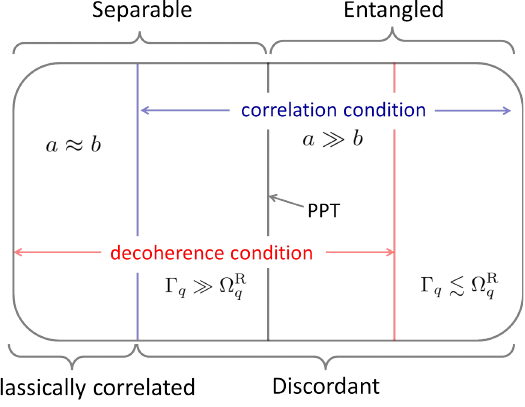
Figure 7. The relation among the quantum correlations of PGWs, the decoherence condition and the correlation condition. In the left side region of the red vertical line, the decoherence condition is satisfied. In the right side region of the blue vertical line, the correlation condition is